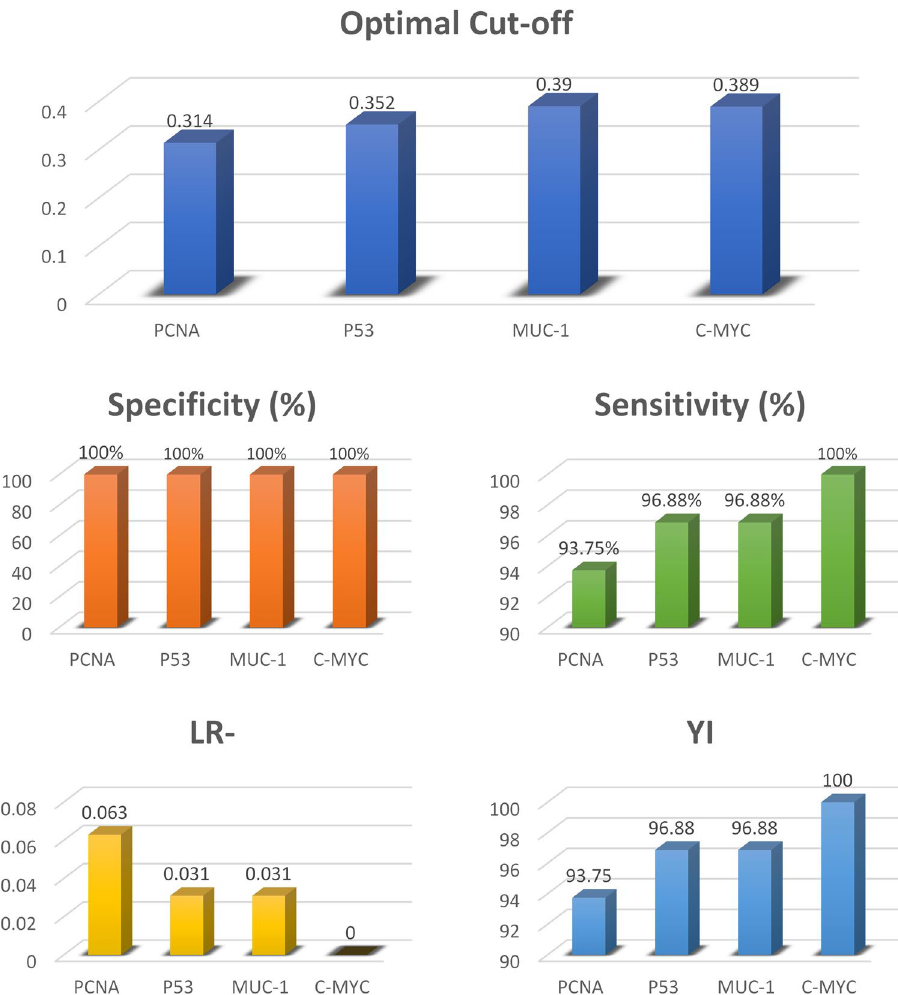
Figure 3. Optimal cut-off values of the four studied AAbs and their corresponding for sensitivity (%), specificity (%), negative likelihood ratio (LR-), and Youden’s index